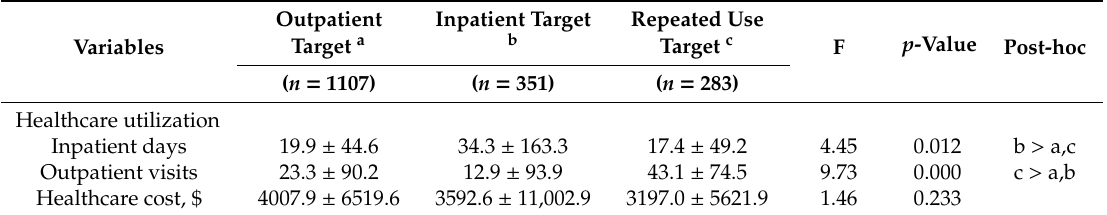
Table 4. Comparison of changes in health care utilization and cost per client by target